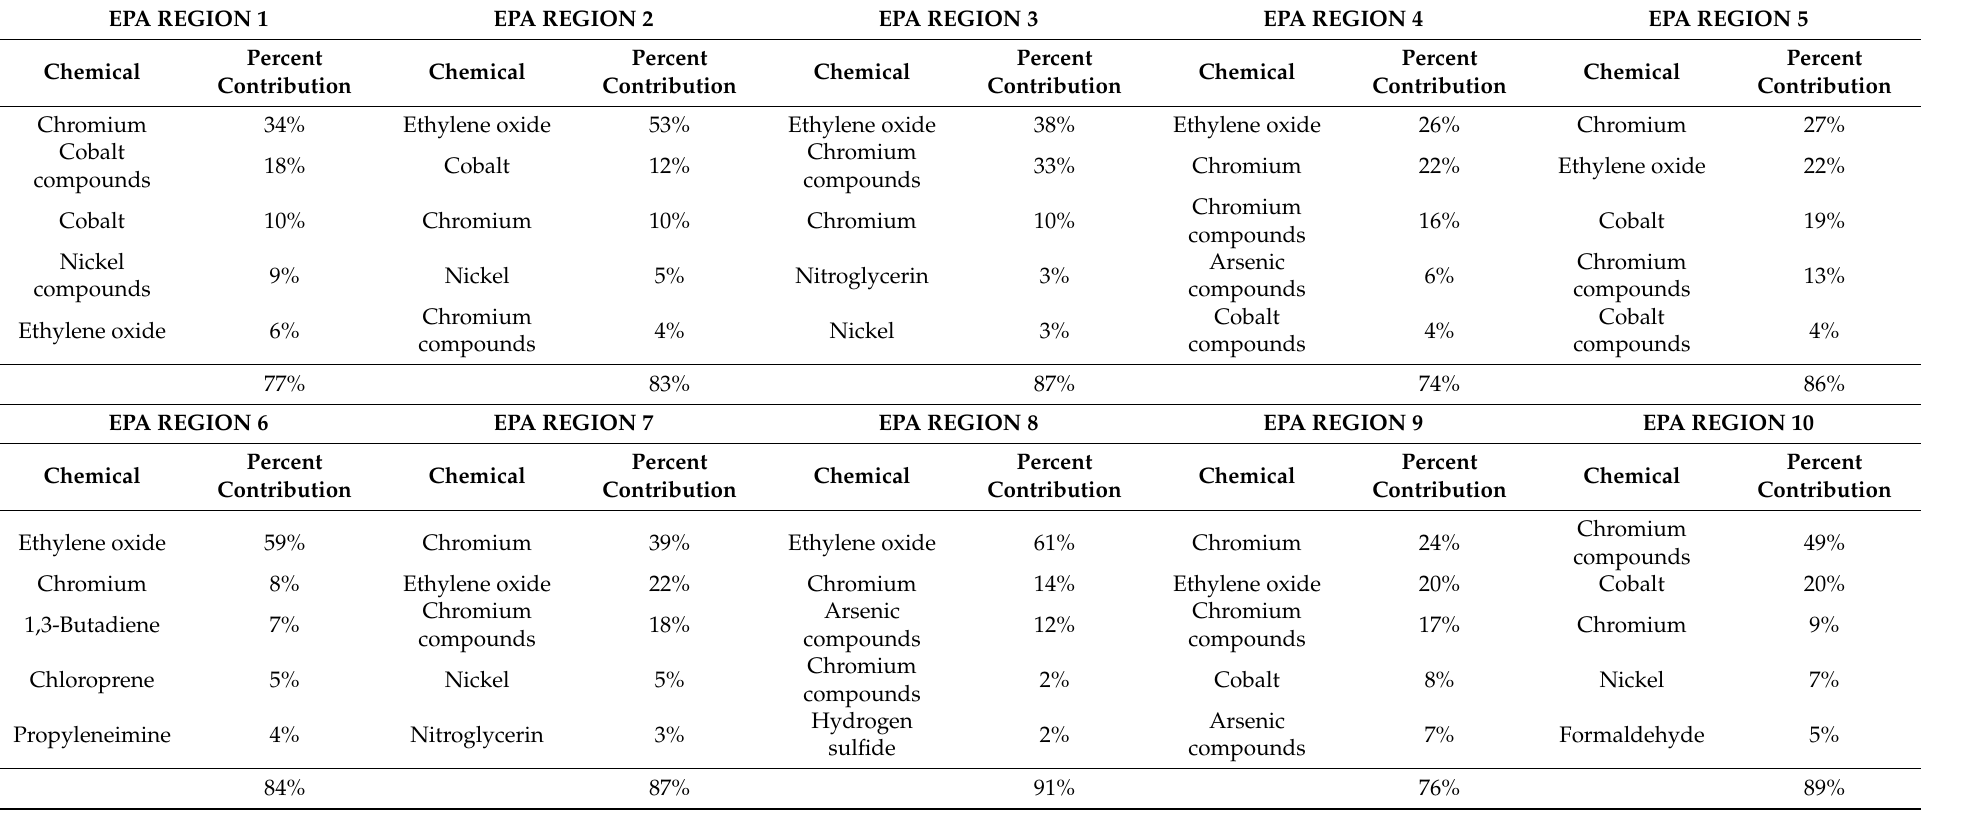
Table 3. The top five chemicals contributing to an EPA region’s health risk from industrial air